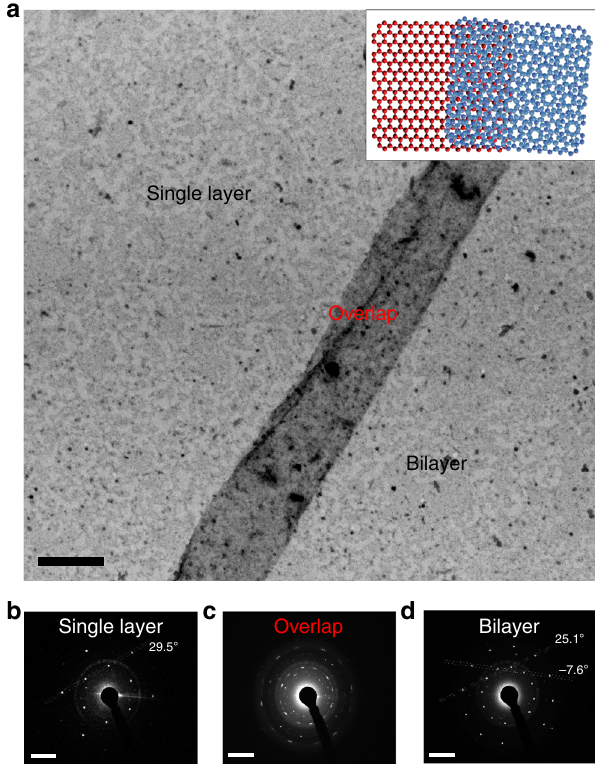
Fig. 3 TEM characterisation of overlapping domains forming nanochannel in graphene fi lm. a TEM image of overlapping domain boundary (darker contrast region) forming extended nanochannel in permeable graphene fi lm; scale bar is 200 nm. SAED patterns (and associated line pro fi les in Supplementary Information) con fi rm the labeled regions as b single-layer graphene with rotation axis of 29.5°, c overlapped domains forming ~250 nm wide nanochannel, d turbostratic bilayer graphene with rotation axes of − 7.6° and 25.1°. b – d Scale bars are 5 nm − 1 . The darker contrast region is con fi rmed as an overlapping mis-oriented graphene domain boundary, or nanochannel, due to the single layer to bilayer transition and shift in the respective rotation axes on either side of the feature. Inset shows representative diagram of an overlapping domain boundary with